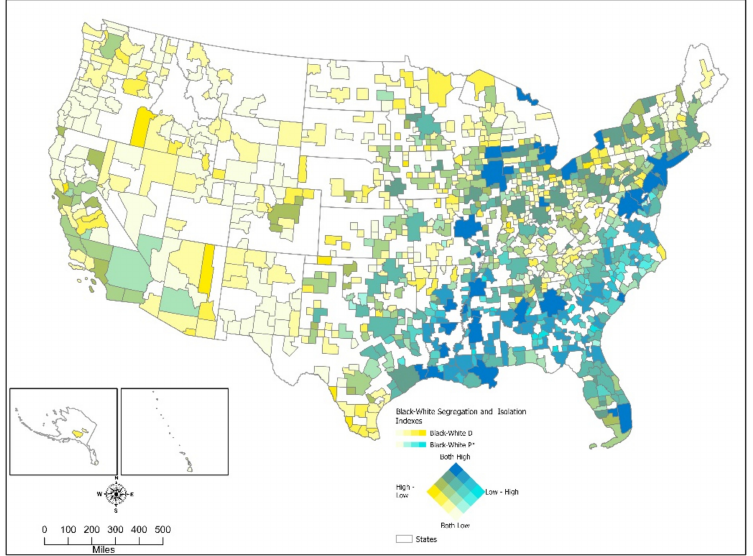
Figure A2. Joint Distribution of Black-White Segregation and Black Isolation,